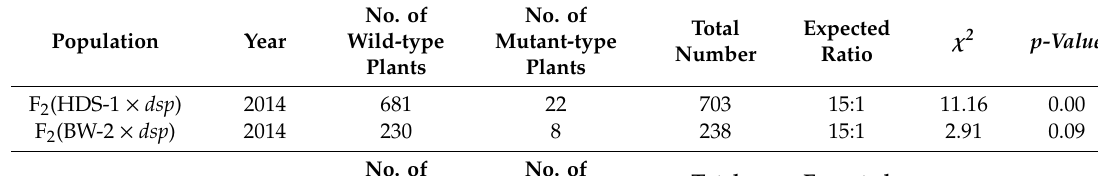
Table 1. Genetic analysis of the short-petiole trait in the F 2 and F 3:4 populations.